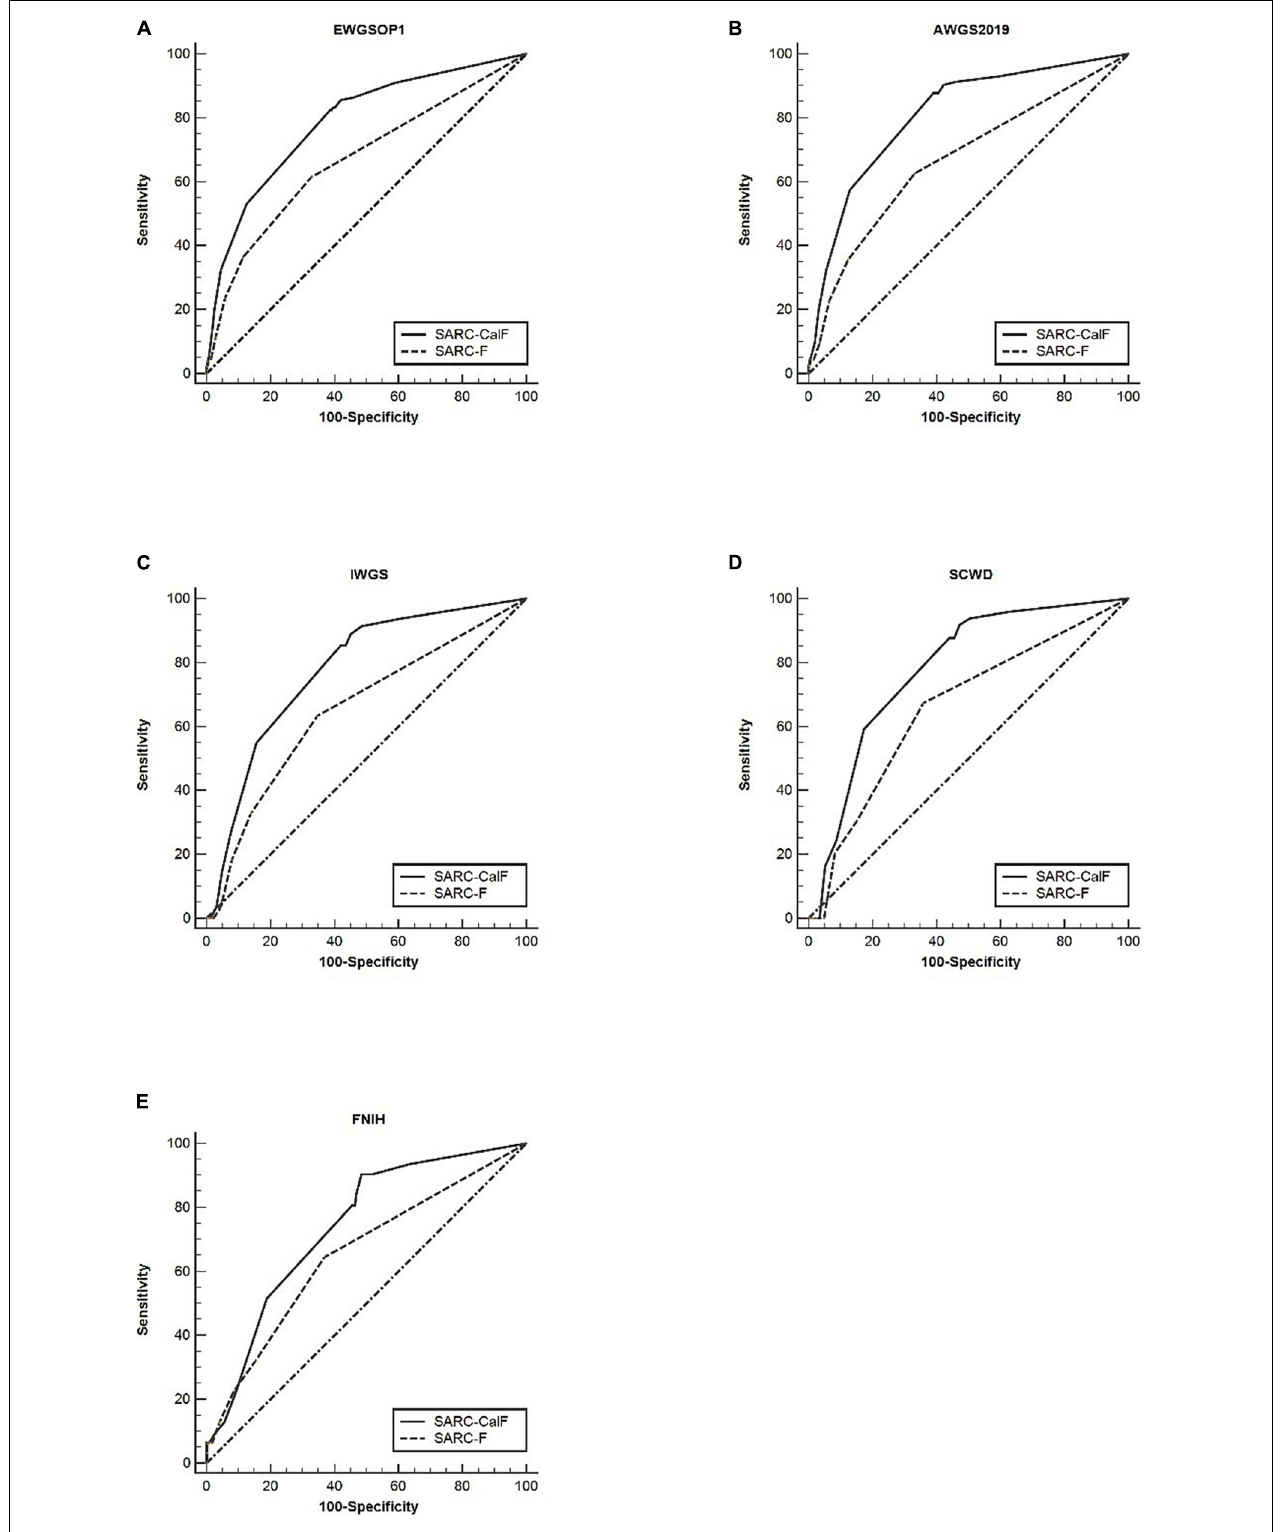
FIGURE 1 | The ROC curves of SARC-F and SARC-CalF were contrasted with various reference standards in the entire population studied: (A) sarcopenia according to the EWGSOP1 criteria; (B) sarcopenia according to AWGS2019 criteria; (C) sarcopenia according to IWGS criteria; (D) sarcopenia according to SCWD criteria; and (E) sarcopenia according to FNIH